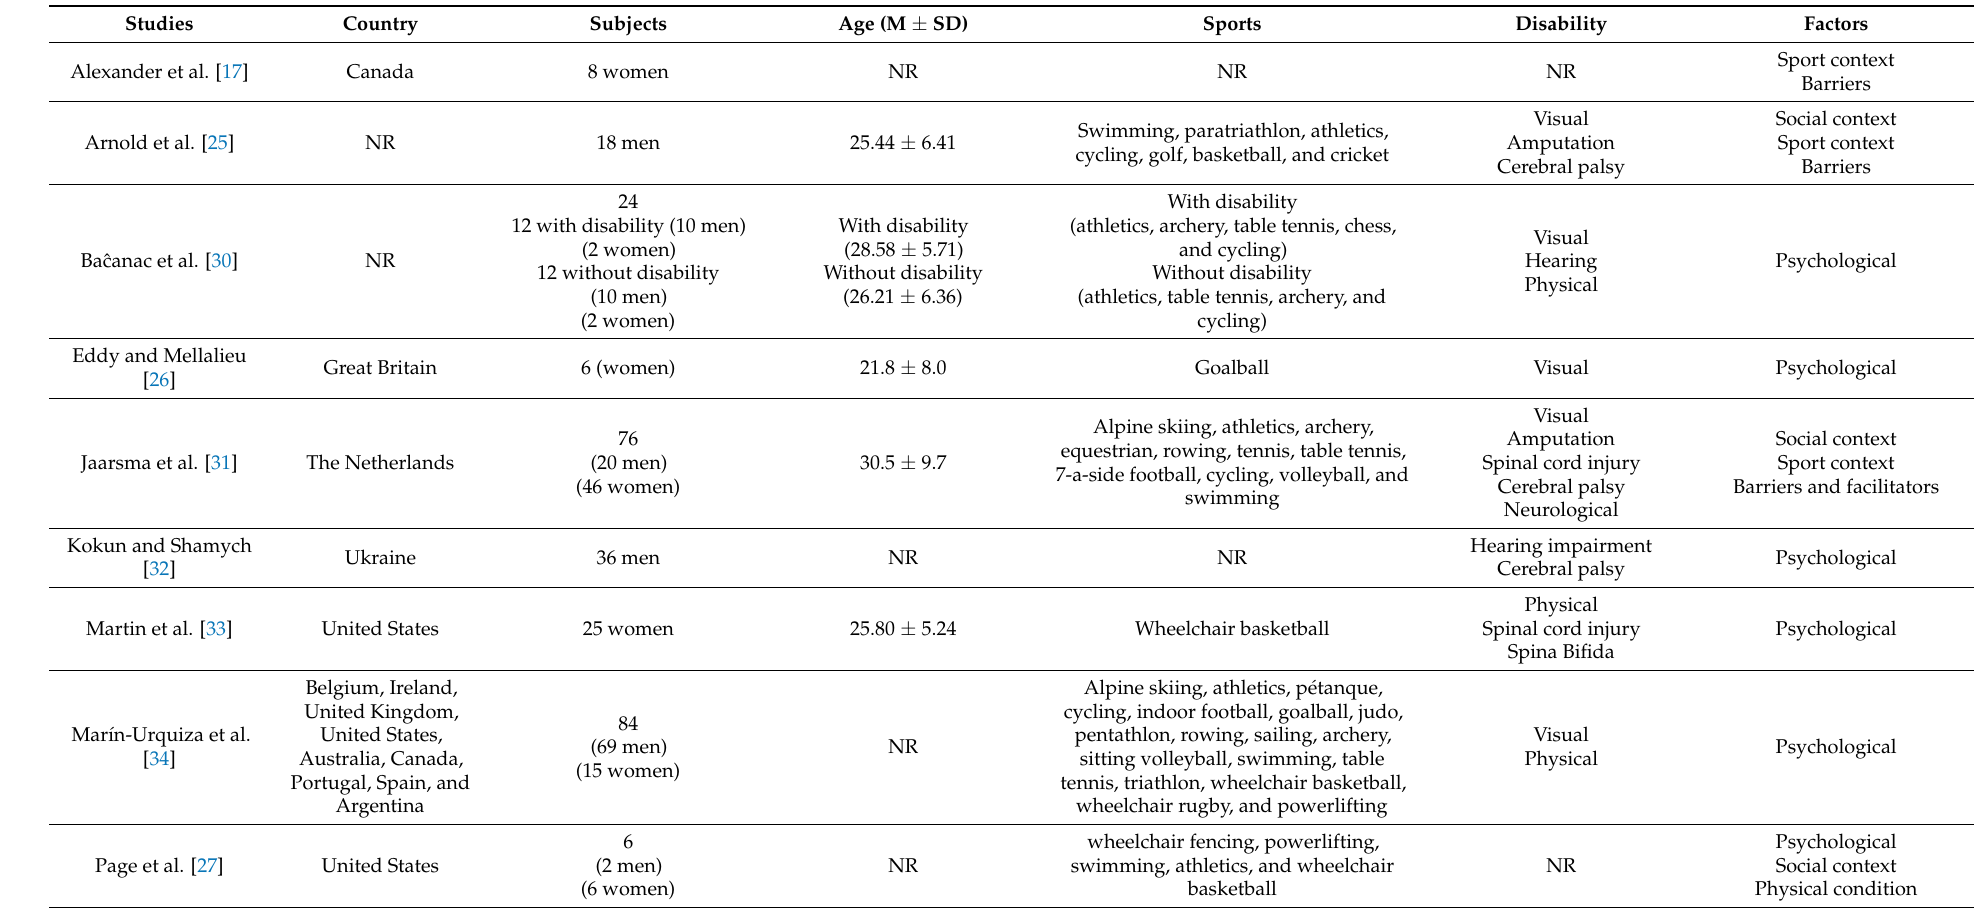
Table 3. Participant characteristics, sports, and factors of the studies included in the systematic